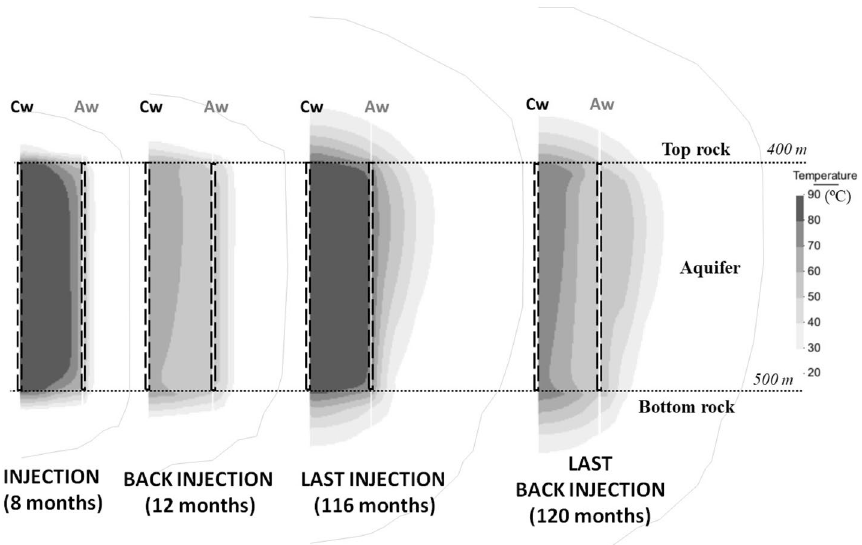
Fig. 10 Isotherms in the aquifer in a radial vertical section from central well (Cw) to one auxiliary well (Aw) at different times: end of the injection and end of the back injection for the first year and the tenth year. Vertical dotted lines represent the wells in the aquifer